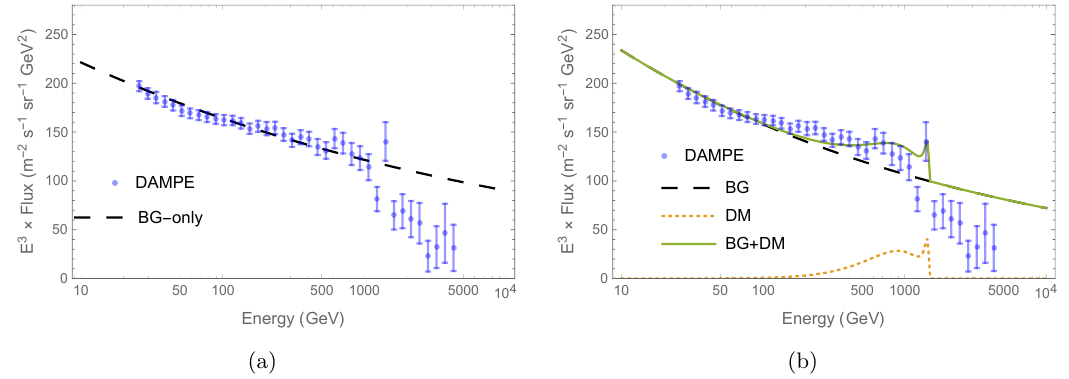
Figure 4 . Cosmic ray electron spectrum (multiplied by E 3 ). The blue points with error bars are the flux measured by DAMPE. (a) The dashed line shows a best-fitting power-law spectrum. The fitting quality is χ 2 / d.o.f. = 101 . 6 / 39 . (b) The solid line shows a combined best-fitting cosmic electron flux. The dashed line shows the cosmic electron background (BG) of the best-fitting. The dotted line shows the flux contributed by DM. The fitting parameters are, F BG = C [ E/ (100 GeV )] − α with C = 1 . 58 × 10 − 4 ( GeV m 2 s sr ) − 1 and α = 3 . 17 , h σv i = 1 . 8 × 10 − 26 cm 3 / φ,φ → η → e + ,e −